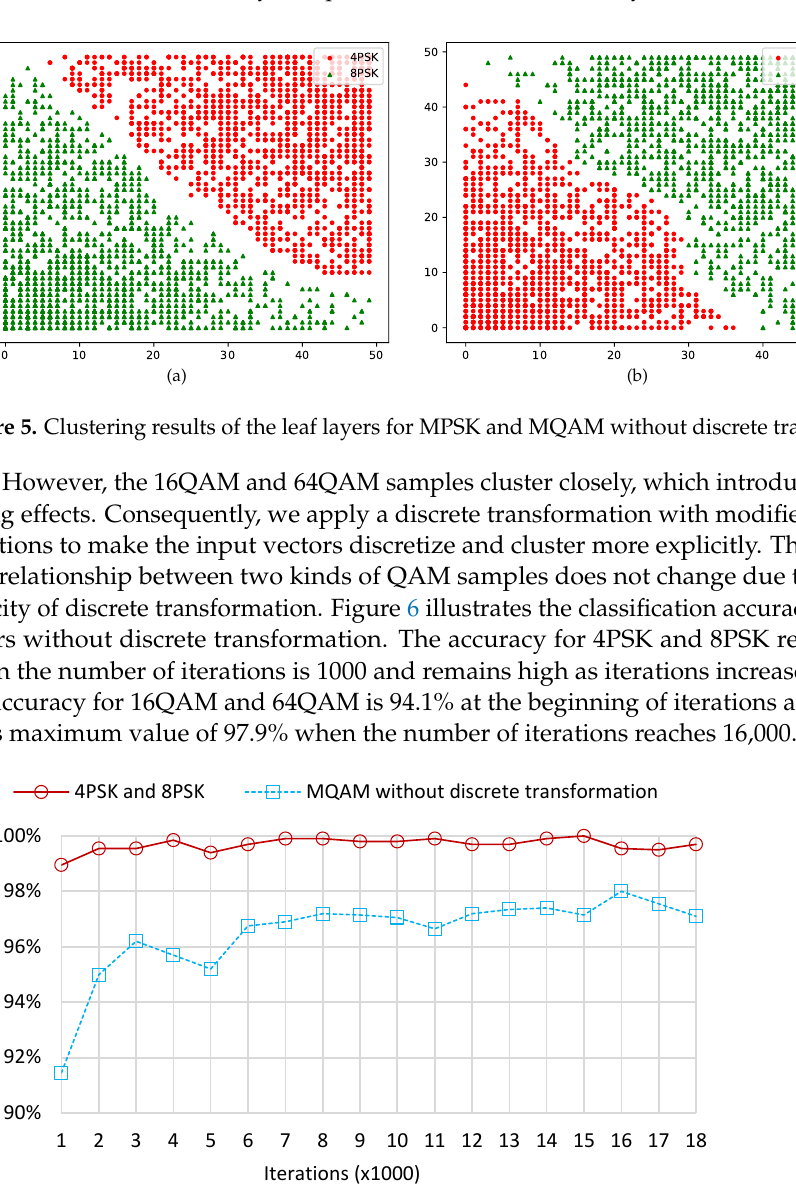
Figure 4. Classification accuracy and quantization error of the root layer.